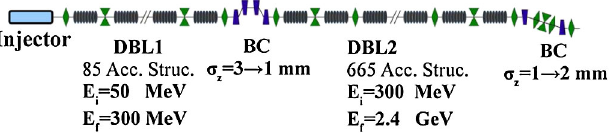
FIG. 3. Basic layout of CLIC drive-beam linac.